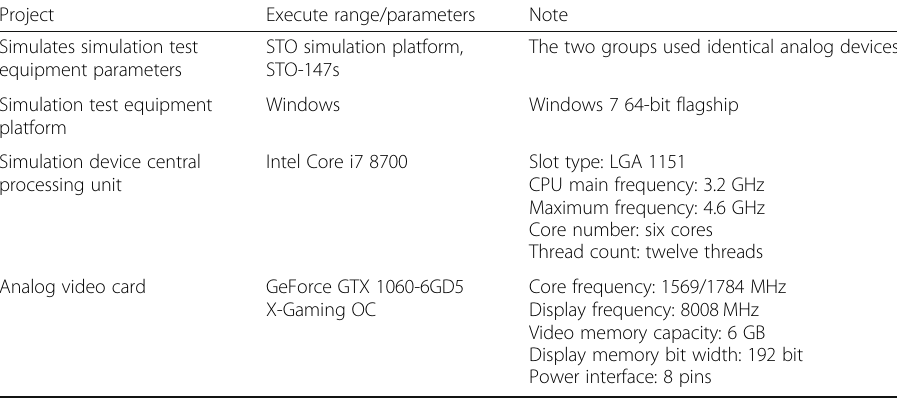
Table 1 Parameter settings of the simulation test Project